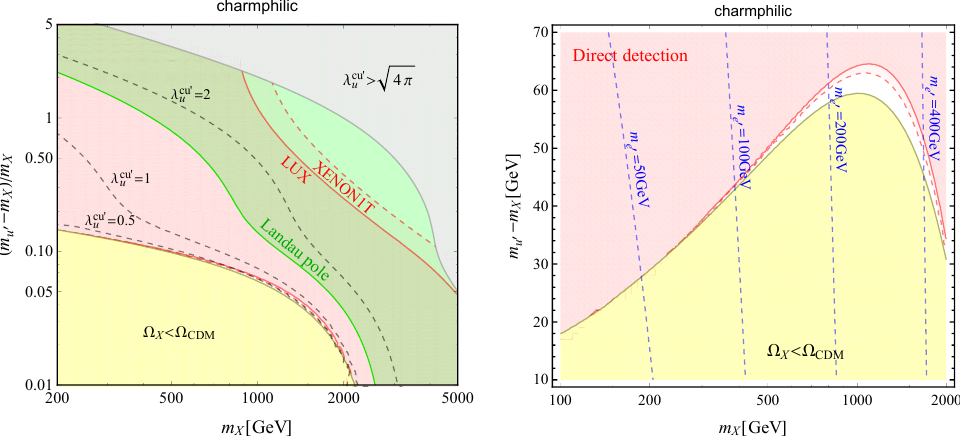
Figure 2 . m vs. the mass di(cid:11)erence between u X lines in the left panel show the contours with (cid:21) cu 0 corresponding mirror electron’s mass. White region in the right panel can satisfy relic abundance and evade various